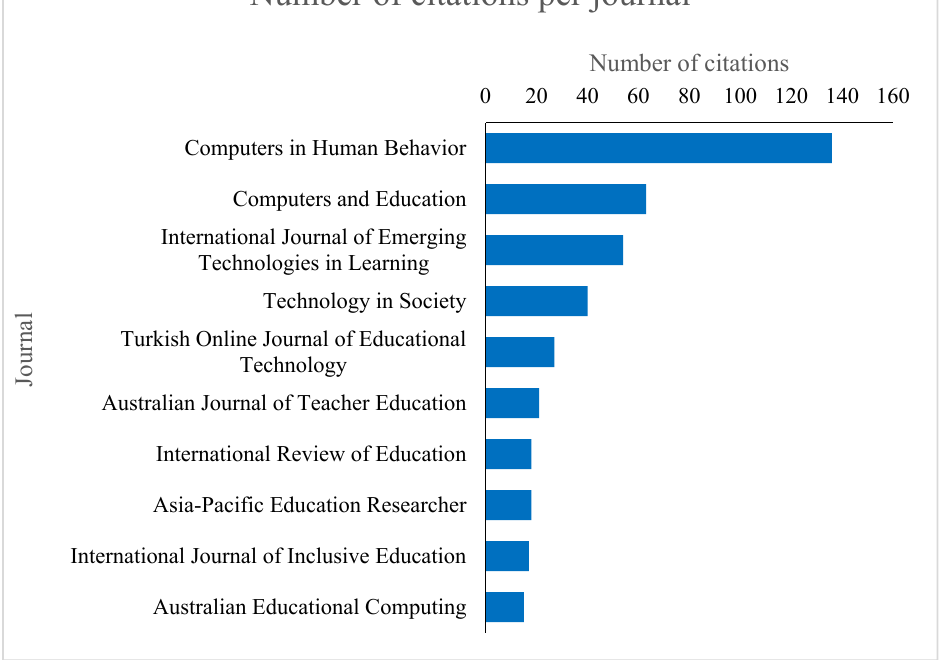
Figure 5. Number of citations per journal. Own elaboration from SCOPUS data.